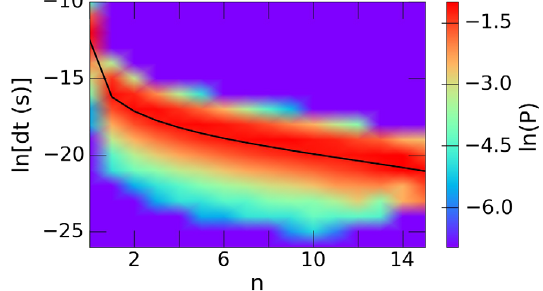
FIG. 19. Probability distribution of the amount of time spent every step, for every n